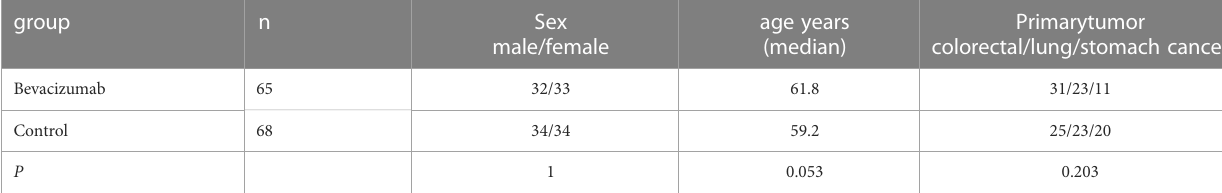
TABLE 2 Comparison of general conditions between the bevacizumab group and control group.